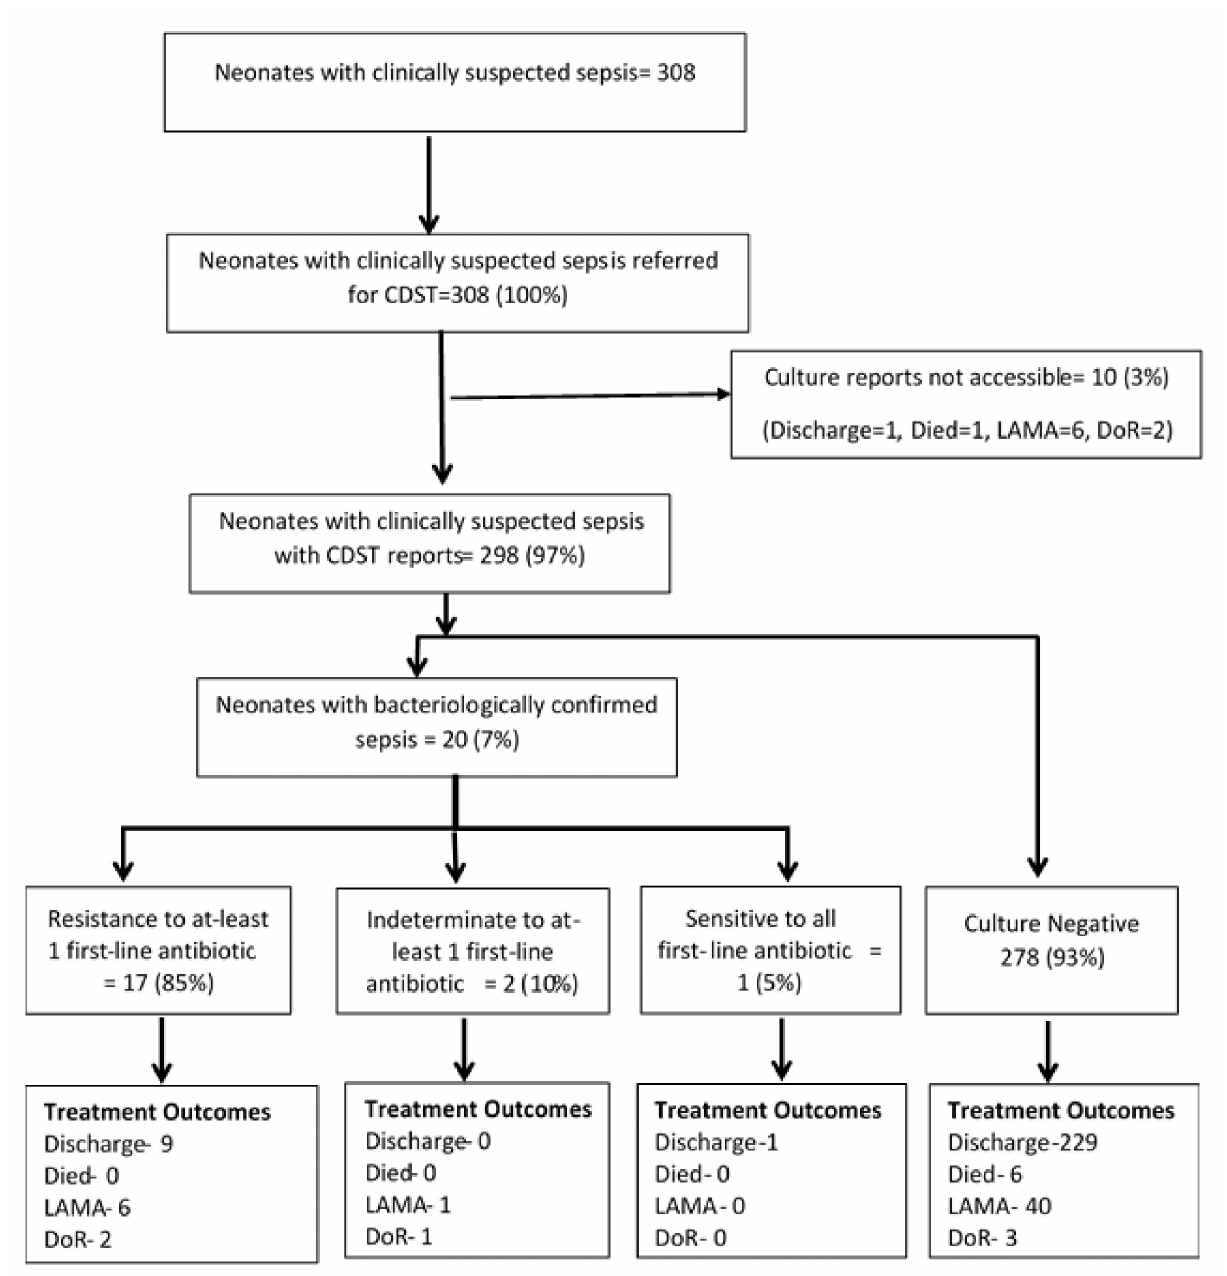
Figure 1. Flow-chart depicting uptake of CDST, bacteriological confirmation, resistance to first-line drugs, and treatment outcomes among neonates with clinically suspected sepsis admitted to NICU at KIST MCTH, Kathmandu Valley, Nepal during June 2018–December 2019. CDST—Culture and drug susceptibility test; NICU—neonatal intensive care unit; LAMA—left against medical advice; DoR—discharge on request; First-line antibiotics—ampicillin, amikacin, gentamicin, and